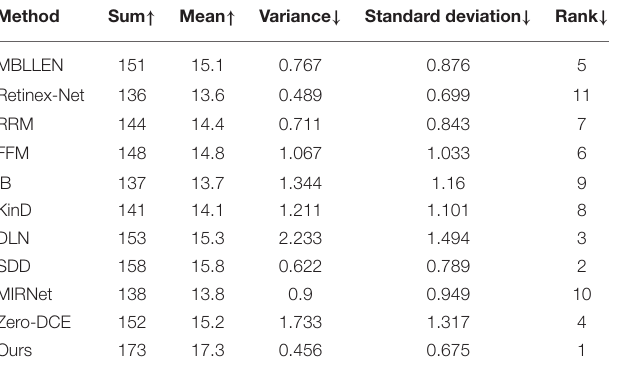
TABLE 4 | Subjective evaluation scores of the enhancement results of 10 low-light images by 20 participants under 11 low-light enhancement methods. Method